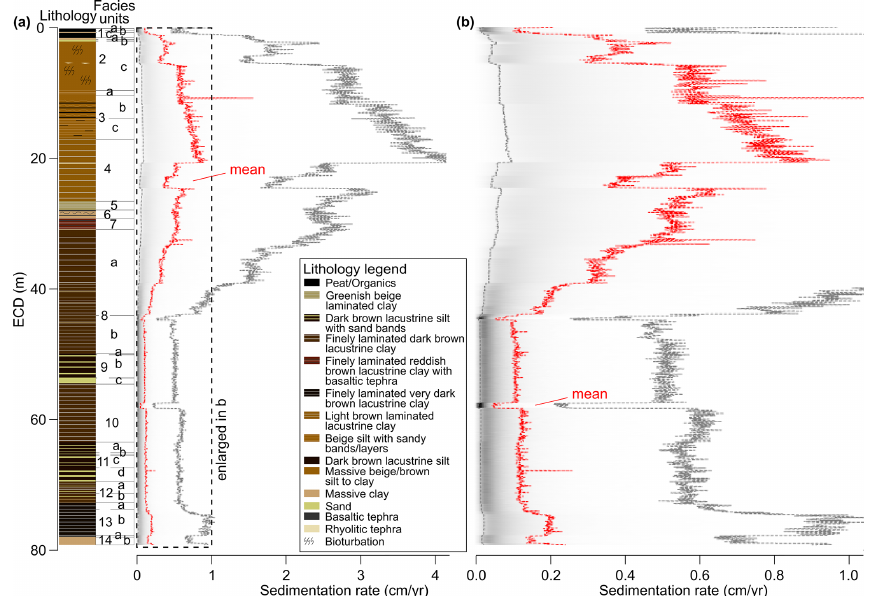
Figure 11. (a) Sedimentation rate variation of the Orakei sediment sequence in centimetres per year from Bacon (Blaauw and Christen, 2020). (b) Enlarged 0–1cmyr − 1 interval from (a) . Dotted red line marks the mean sedimentation rate; dotted grey lines mark the 95% confidence limits obtained by Bacon. Simplified lithology and facies units from Peti and Augustinus